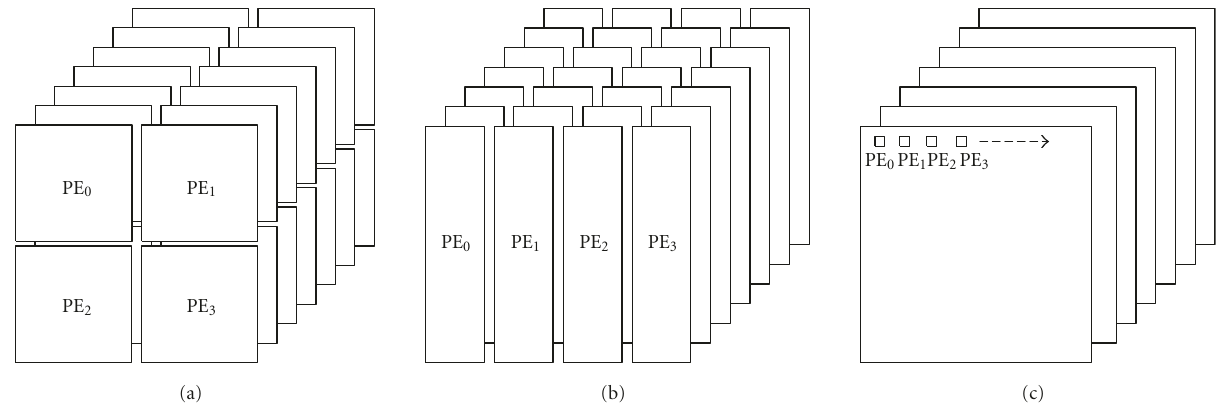
Figure 12: Cube data partitioning where the number of processing elements ( N PE ) is 4.